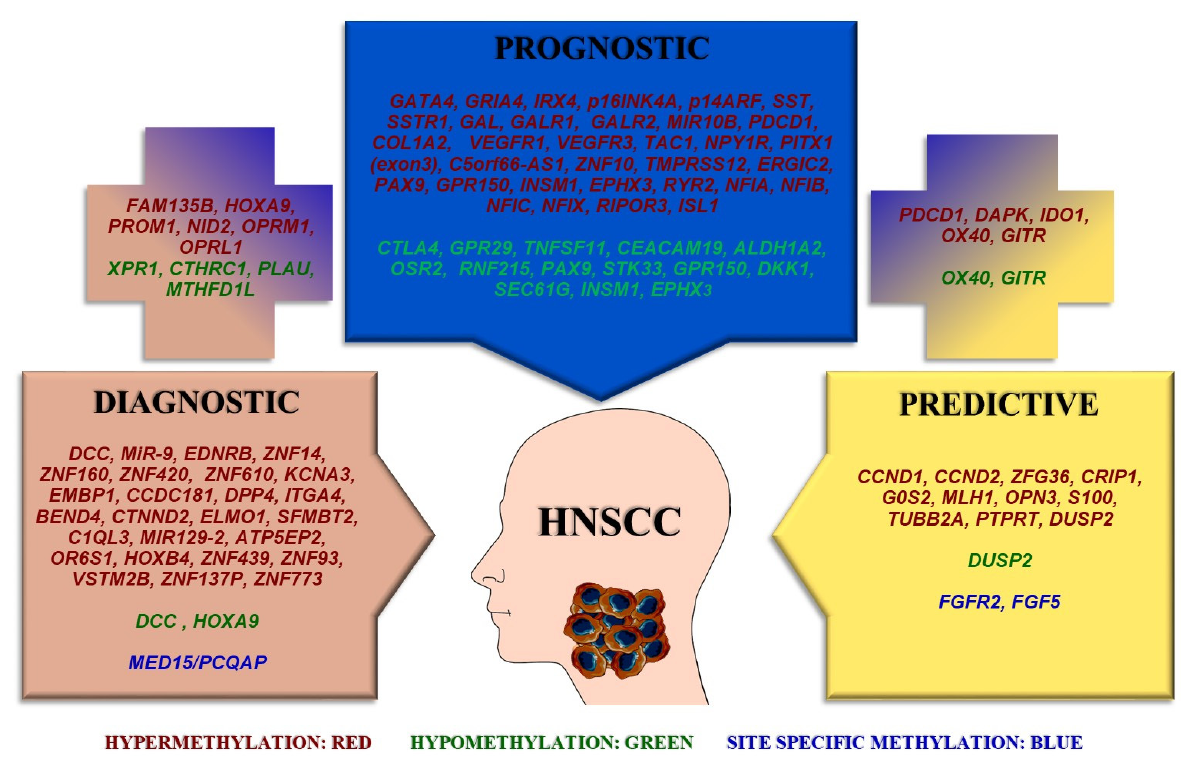
Figure 1. Differentially methylated genes as biomarkers with diagnostic, prognostic, and predictive value in HNSCC. Cancer is a multifactorial disease that depends on the accumulation of both genetic mutations and epigenetic alteration. DNA methylation is one of the major epigenetic mechanisms that enable gene activation or inactivation during tumorigenesis. As such, the methylation profile of patients with HNSCC represents a potential source for new biomarker identification and more ideal patient stratification. Hypermethylation, hypomethylation and site-specific methylation of genes could be utilized as diagnostic, prognostic, and predictive tools. The genes included in the plus signs have dual roles, i.e., either both diagnostic and prognostic (left) or both prognostic and predictive (right).